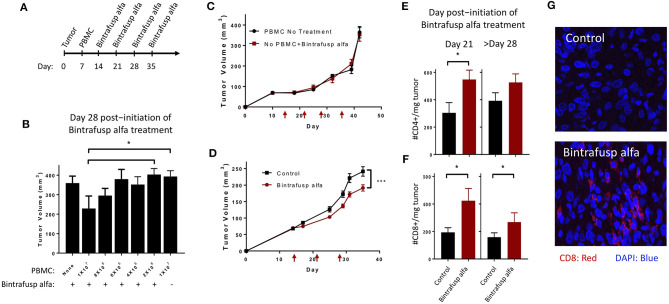
Bintrafusp alfa treatment results in anti-tumor efficacy in the HTB-1 subcutaneous bladder model. (A) Timeline of tumor injection, human PBMC engraftment, and bintrafusp alfa treatments. (B) Titration of the number of human PBMCs and their effect on bintrafusp alfa-mediated anti-tumor efficacy on day 28 post-initiation of bintrafusp alfa treatment (n > 4; *p < 0.05, student's t-test, error bars represent mean ± SEM). (C) Average growth curves of HTB-1 s.c. tumors in animals treated with bintrafusp alfa in the absence of human PBMCs (red) or in the presence of human PBMCs without bintrafusp alfa (black) (n ≥ 7). (D) Average growth curves of HTB-1 s.c. tumors in control-Ig and bintrafusp alfa-treated mice (data combined from 3 independent experiments, n ≥ 26, 2-way ANOVA, ***p < 0.0001; red arrows indicate bintrafusp alfa administration). HTB-1 tumor T-cell infiltrates for both CD4+
(E) and CD8+
(F) T cells per milligram tumor weight at day 21 (left, n = 9), or after day 28 (right, n = 22) post-initiation of bintrafusp alfa treatment. Error bars represent mean ± SEM; *p < 0.05. (G) Representative immunofluorescent images at day 28 post-initiation of bintrafusp alfa treatment, comparing CD8+ expression (red) in HTB-1 tumors from IgG control vs. bintrafusp alfa-treated mice.